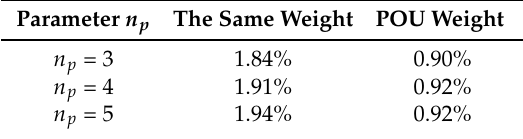
Table 5. Comparison of drift KITTI training dataset between POU Weight and the Same